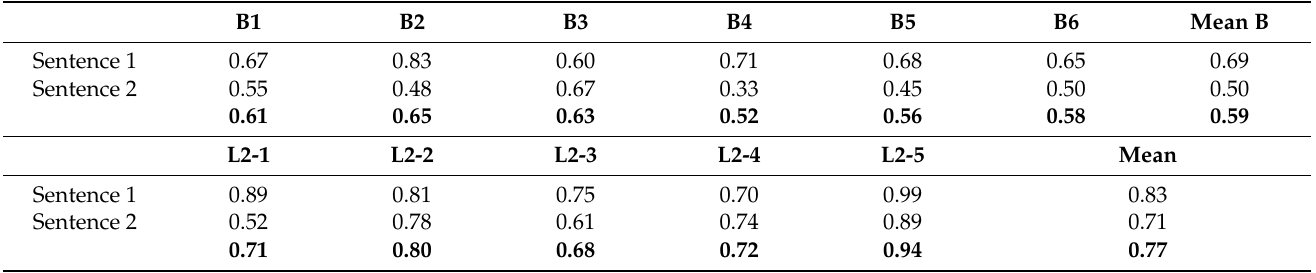
Table 9. Deviation from L1 Turkish mean (L1-TR) based on normalized F0 values (upper panel: HL